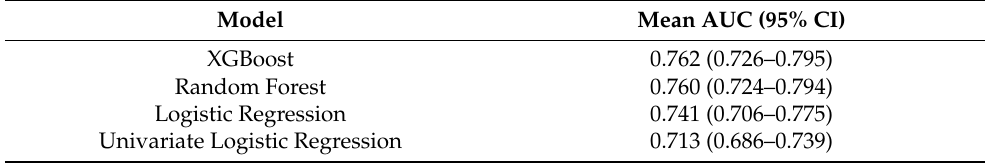
Table 4. Model performances for predicting lymph node metastasis (entire population).